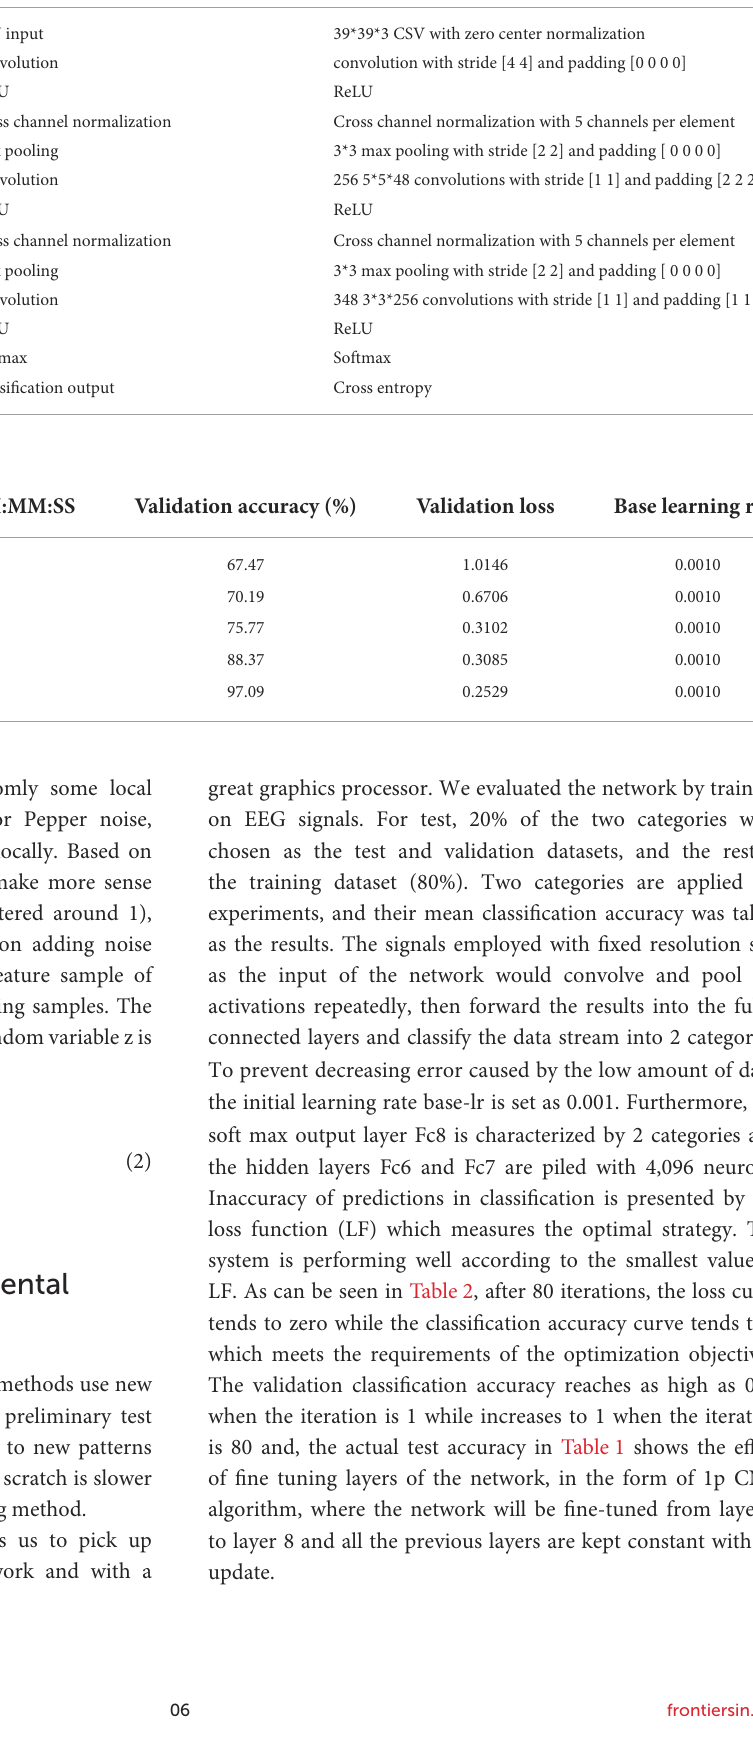
TABLE 1 The principal parameters of the convolutional neural network (CNN) design.